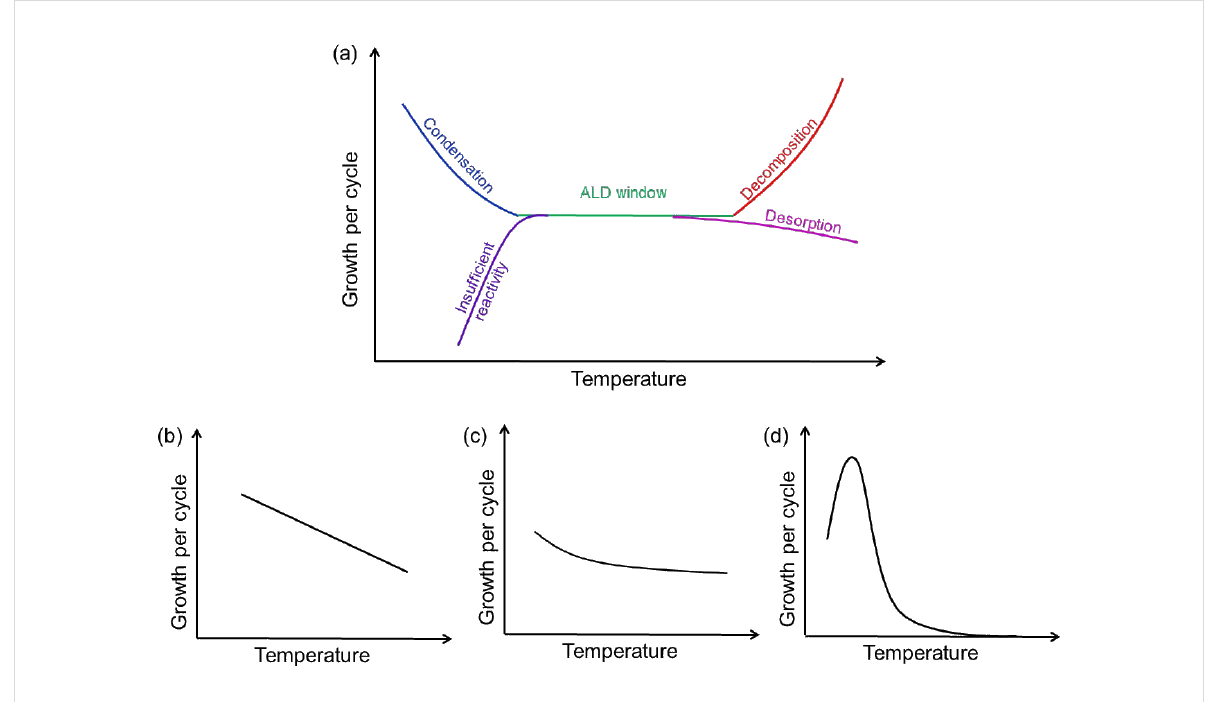
Figure 4: Dependence of the film growth on the deposition temperature: (a) within the so-called ALD window the growth per cycle remains constant with increasing temperature, whereas (b)–(d) represent typical cases in which no temperature range of constant growth is seen, but the process may yet be highly reproducible.